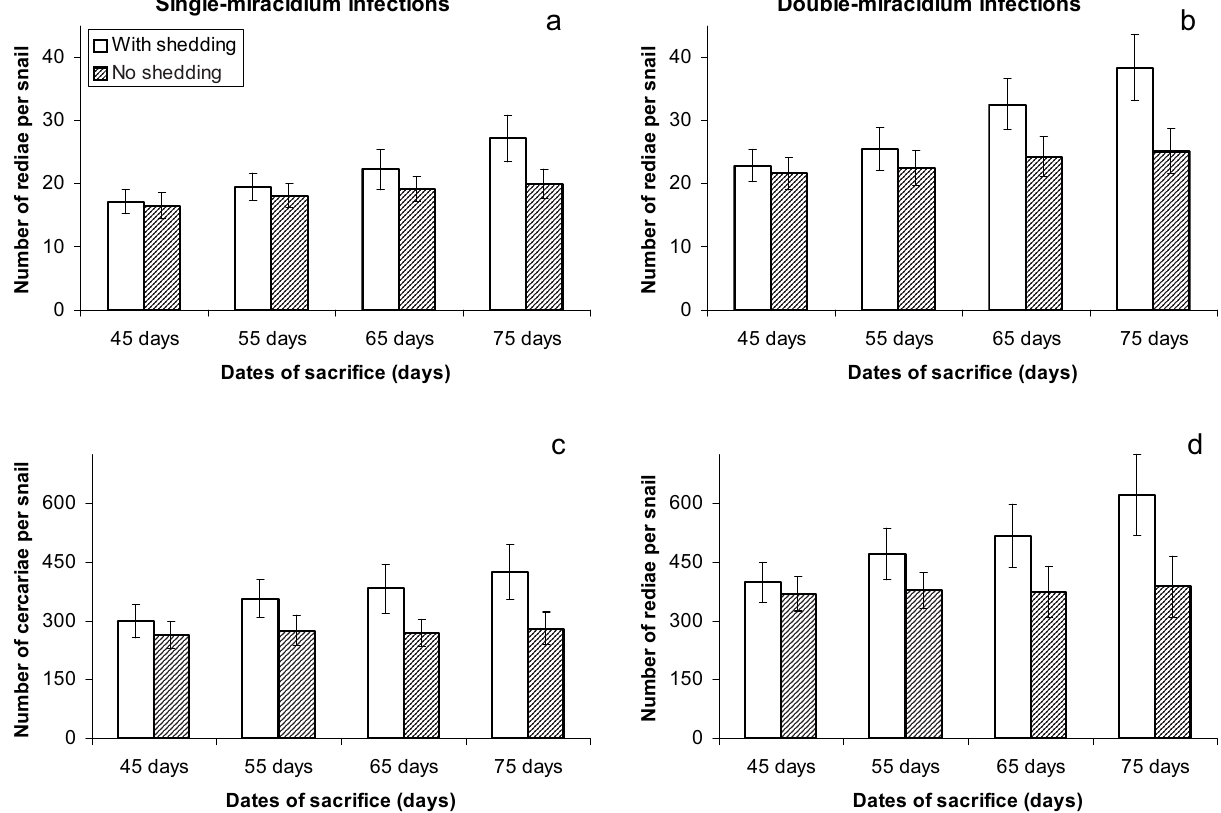
Fig. 1. – Mean values and S.D. for the number of F. hepatica rediae (a, b) and that of cercariae (c, d) in single-miracidium infections of G. truncatula (a, c) and in double-miracidium ones (b, d) in relation to the length of experiment and the existence or the absence of cer- carial shedding before each date of snail